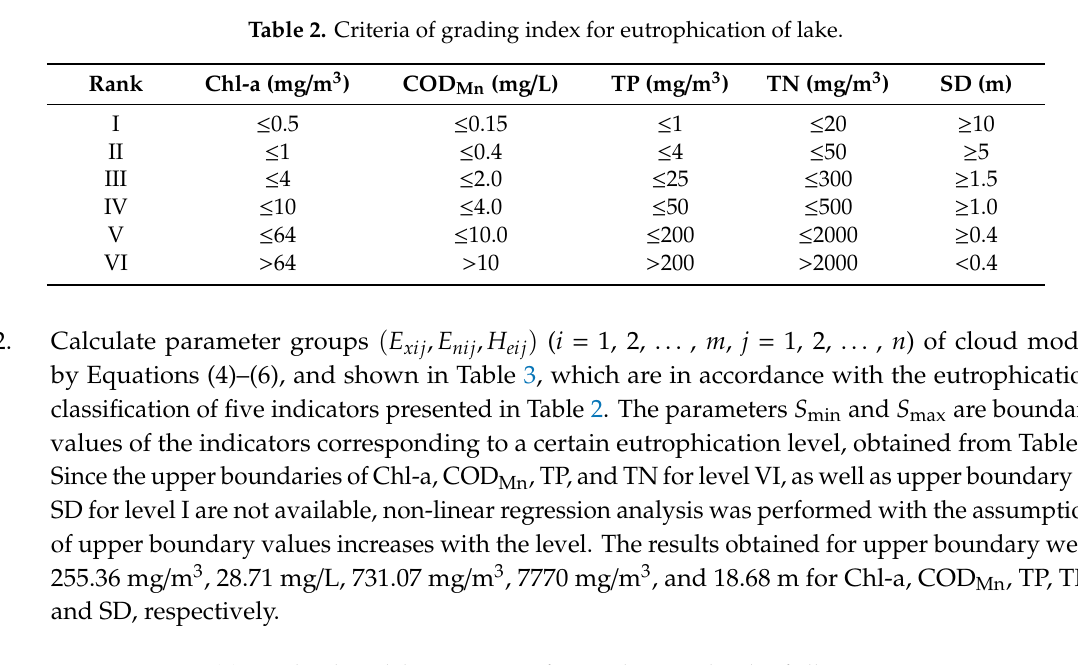
Table 3. Cloud model parameters of eutrophication levels of all